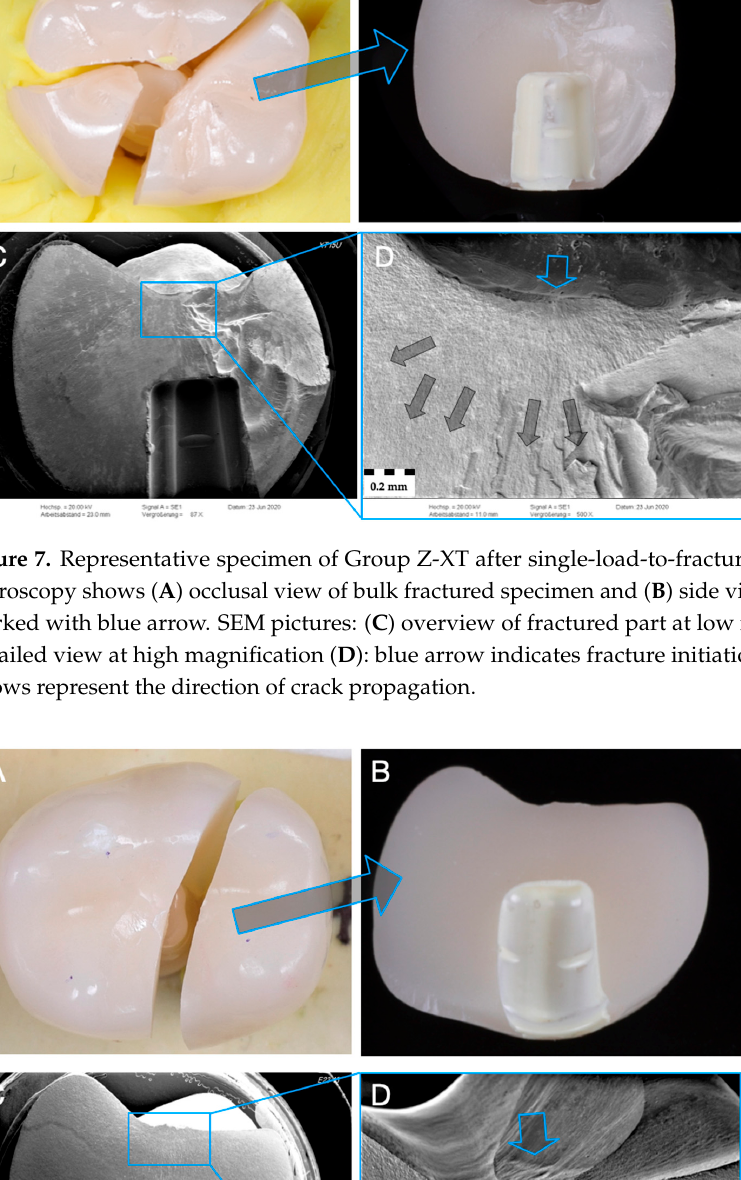
dark arrows represent the direction of crack propagation.